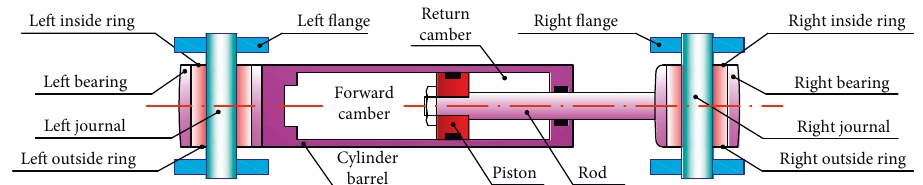
Figure 1: Model of the hydraulic cylinder with two clearances on bilateral sides.